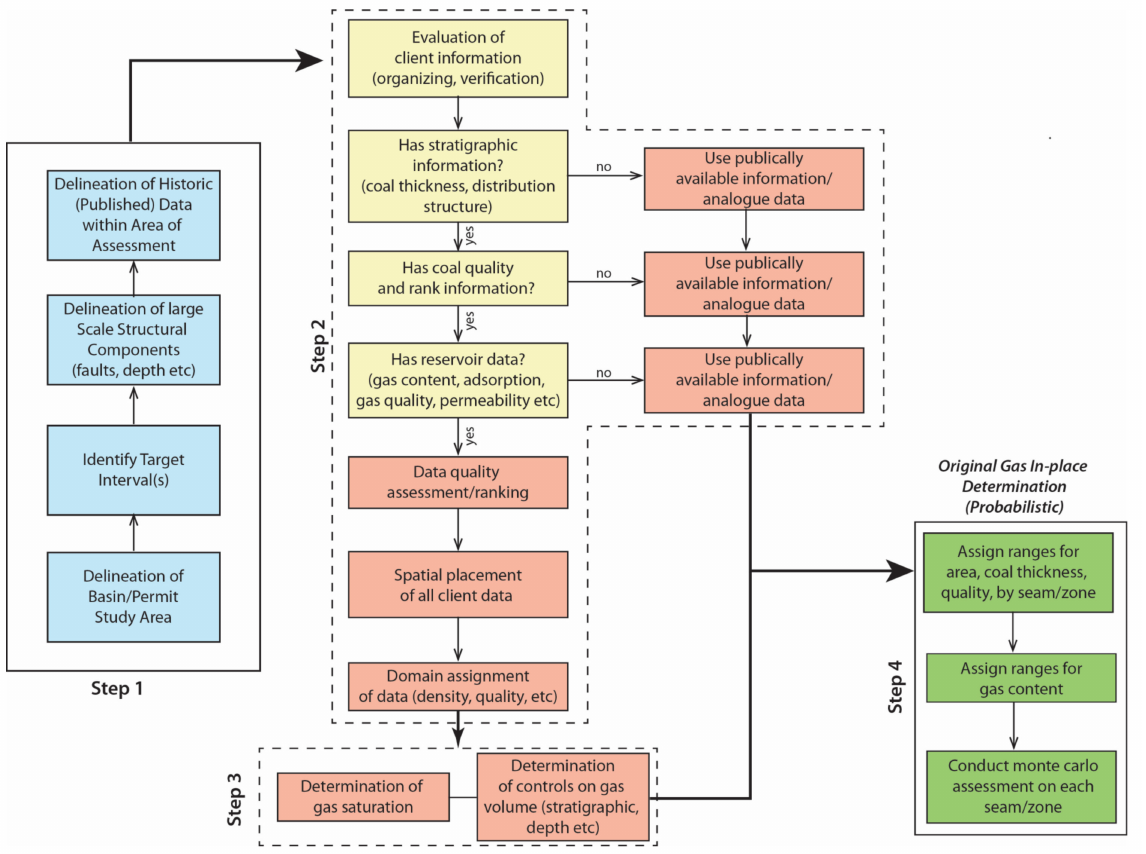
Figure 12. One possible workflow scenario for determination of original gas in place